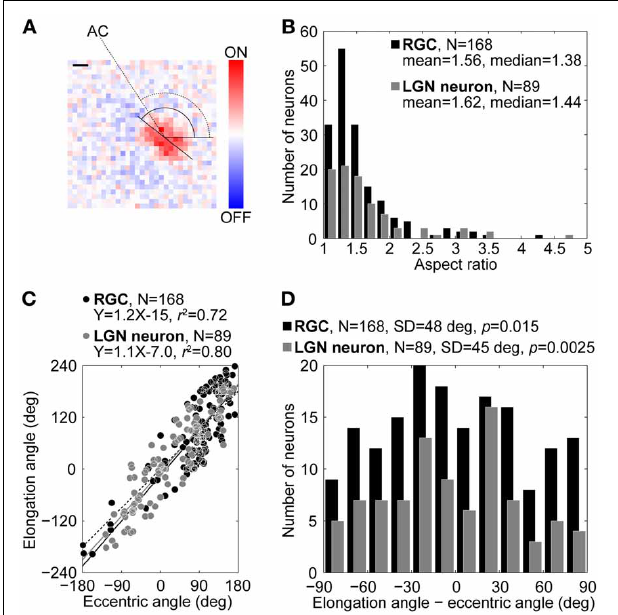
FIGURE 1 | Comparison of RF structures of RGCs and LGN neurons. (A) Example of a RF structure of an ON-center RGC at the peak response latency (40ms). Reddish and bluish colors indicate ON- and OFF-responses, respectively. The aspect ratio, elongation angle (solid arc) of the center region, and eccentric angle (dotted arc) were 1.38, 142, and 123 ◦ , respectively. AC indicates the area centralis . Scale bar = 1 ◦ . (B–D) Distributions of the aspect ratios (B) , relationship between the elongation and eccentric angles (see details in text) (C) , and distributions of differences between elongation and eccentric angles (D) . Black and gray bars/circles indicate RGCs and LGN neurons,